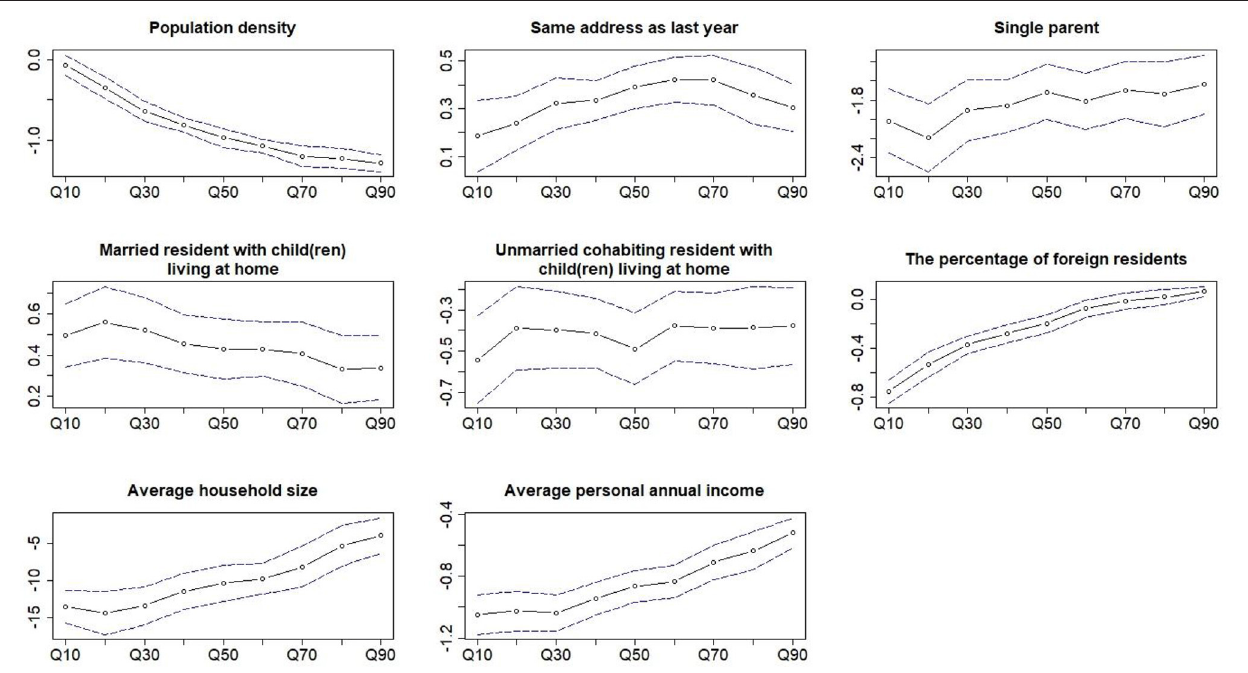
FIGURE 1 | Coefficients of the multivariable quantile regression of all the covariates as a function of the different quantiles of the coverage in the BCSP. The dotted line and the blue dash lines are the coefficient and the 95% CI of quantile regression at the different quantiles of the outcome.